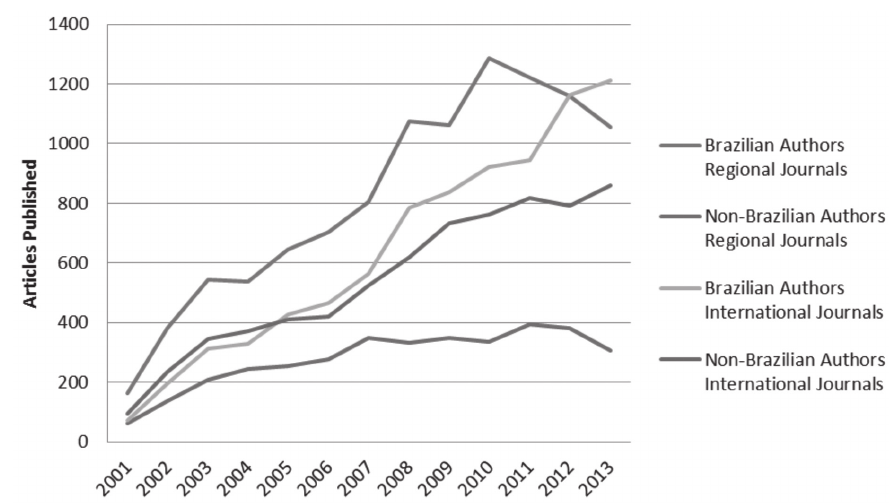
Figure 2 . Publication Counts and Outlet Type for Latin American Authors: